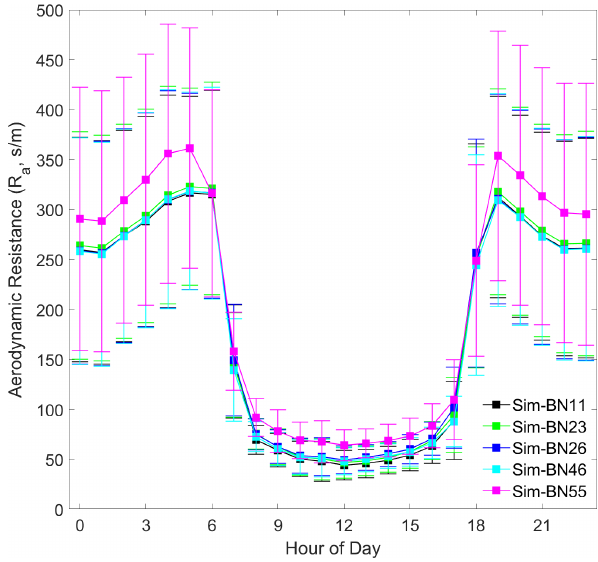
Figure 4. Diurnal variation of observed and simulated V d .